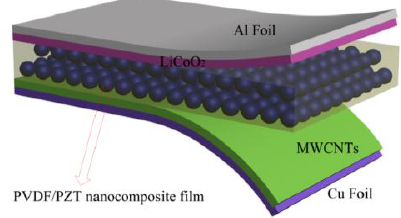
Figure 5. Self-charging Li battery using PVDF-PZT nanoparticle composite separator [77].